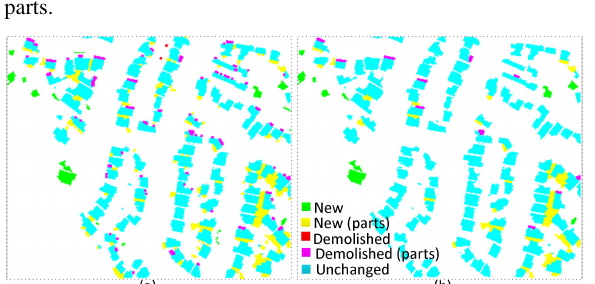
Figure 6: Building change detection in Scene 2: larger than (a) 9 m 2 and (b) 25 m 2 (small regions removed).